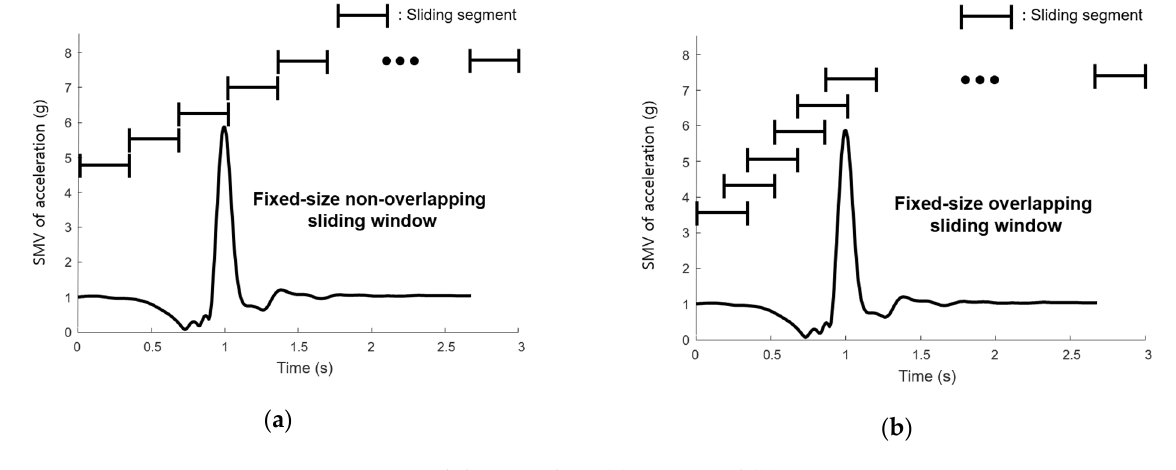
Figure 4. Sliding window: ( a ) FNSW and ( b ) FOSW.